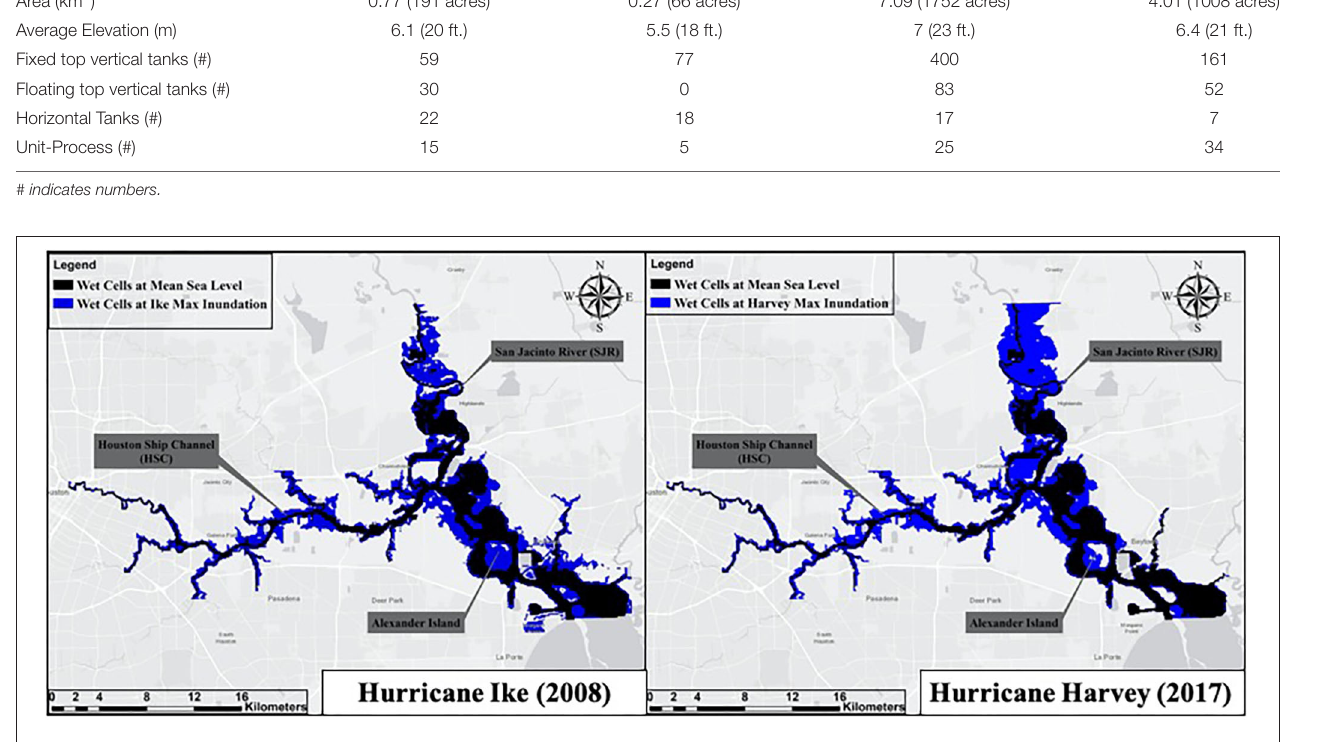
FIGURE 5 | Comparison of maximum inundated areas for Hurricane Ike (left) and Hurricane Harvey